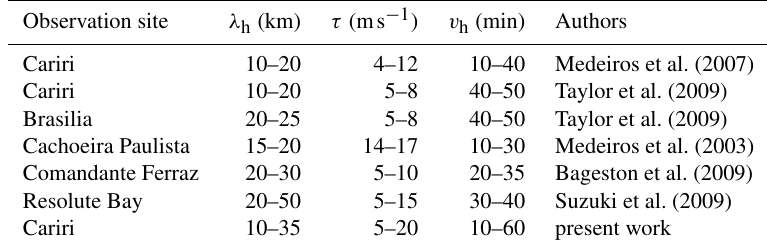
Table 3. Summary of the main distribution of SSGW characteristics at different observation sites.